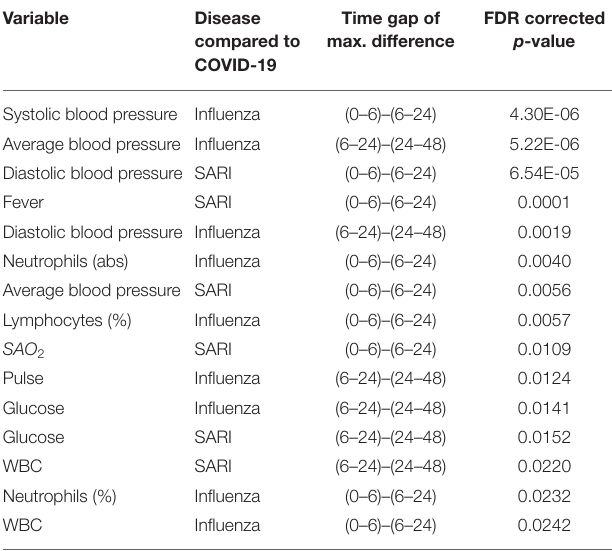
TABLE 5 | Significant slope difference in time window during the first day or the second day of